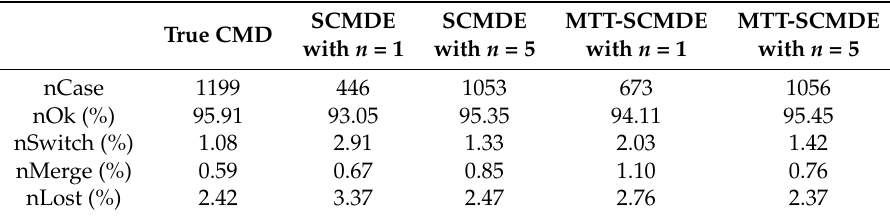
Table 1. Track retention statistics for Monte Carlo